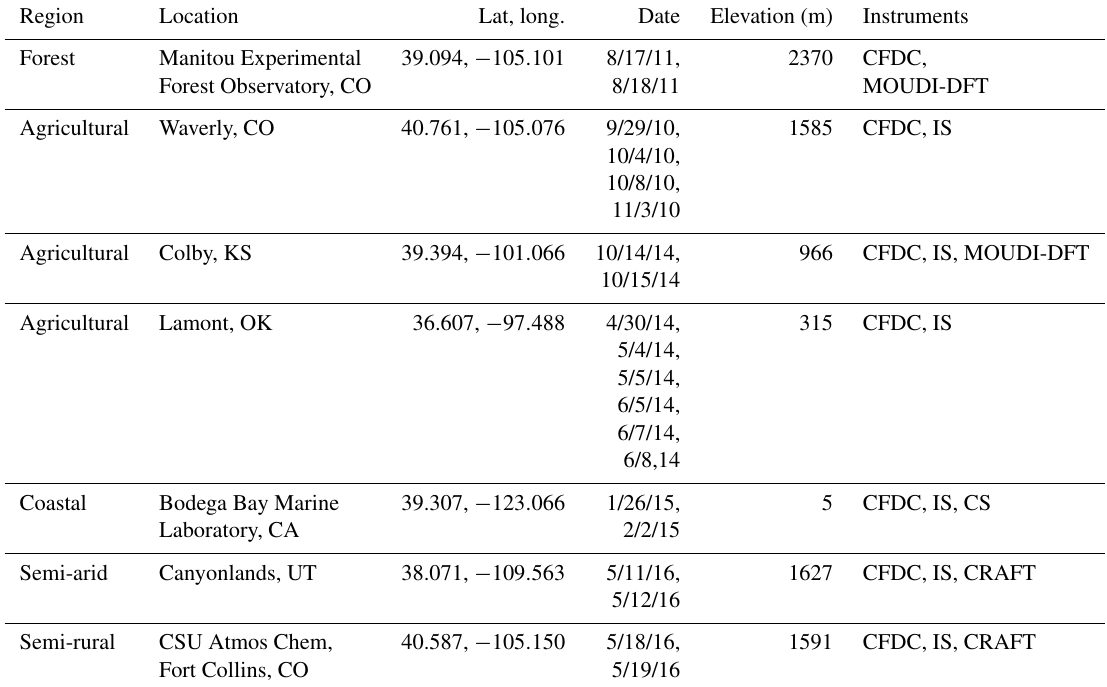
Table 2. Sampling locations, elevations, dates and instruments involved in sampling at field sites when the CFDC sampled at varied tempera- tures during integral offline collections. All sampling at these sites was by filters except for the use of a BioSampler for the CS at Bodega Bay Marine Laboratory, the IS at Waverly, and the MOUDI-DFT at Manitou Experimental Forest (Huffman et al., 2013) and Colby (Mason et al., 2015). CFDC data from Manitou Experimental Forest are from Tobo et al. (2013). Data from Waverly, CO, are from Garcia et al. (2012). Region Location Lat,